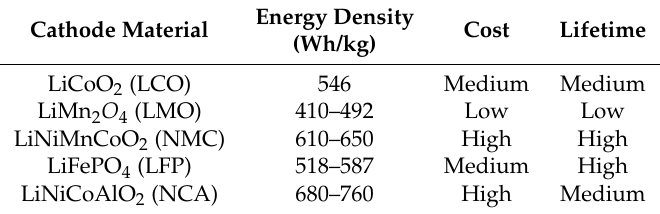
Table 4. Cathode materials—Overview including energy density cost and